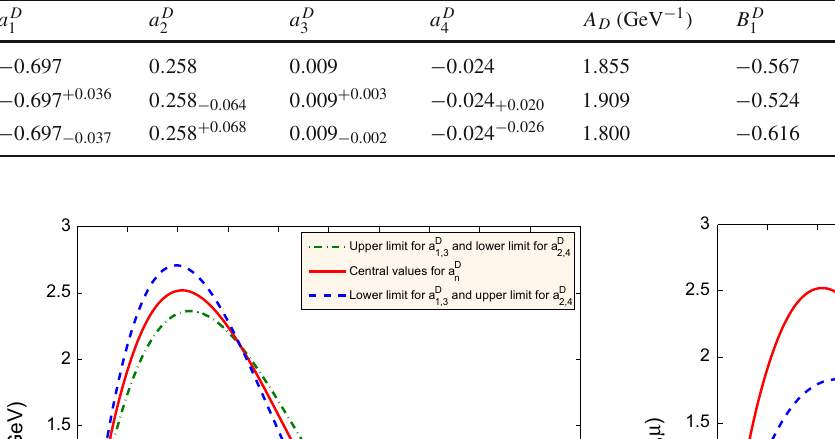
Table 4 Typical D -meson leading-twist DA model parameters at scale μ = 2GeV